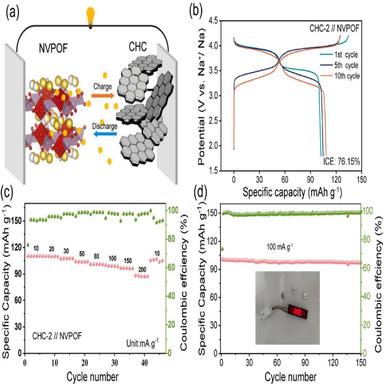
(a) schematic diagram, (b) charge-discharge curve, (c) Rate capability of CHC-2||NVPOF full cell; (d) Cycling performance with the illustration shows the LED symbol powered by a battery.